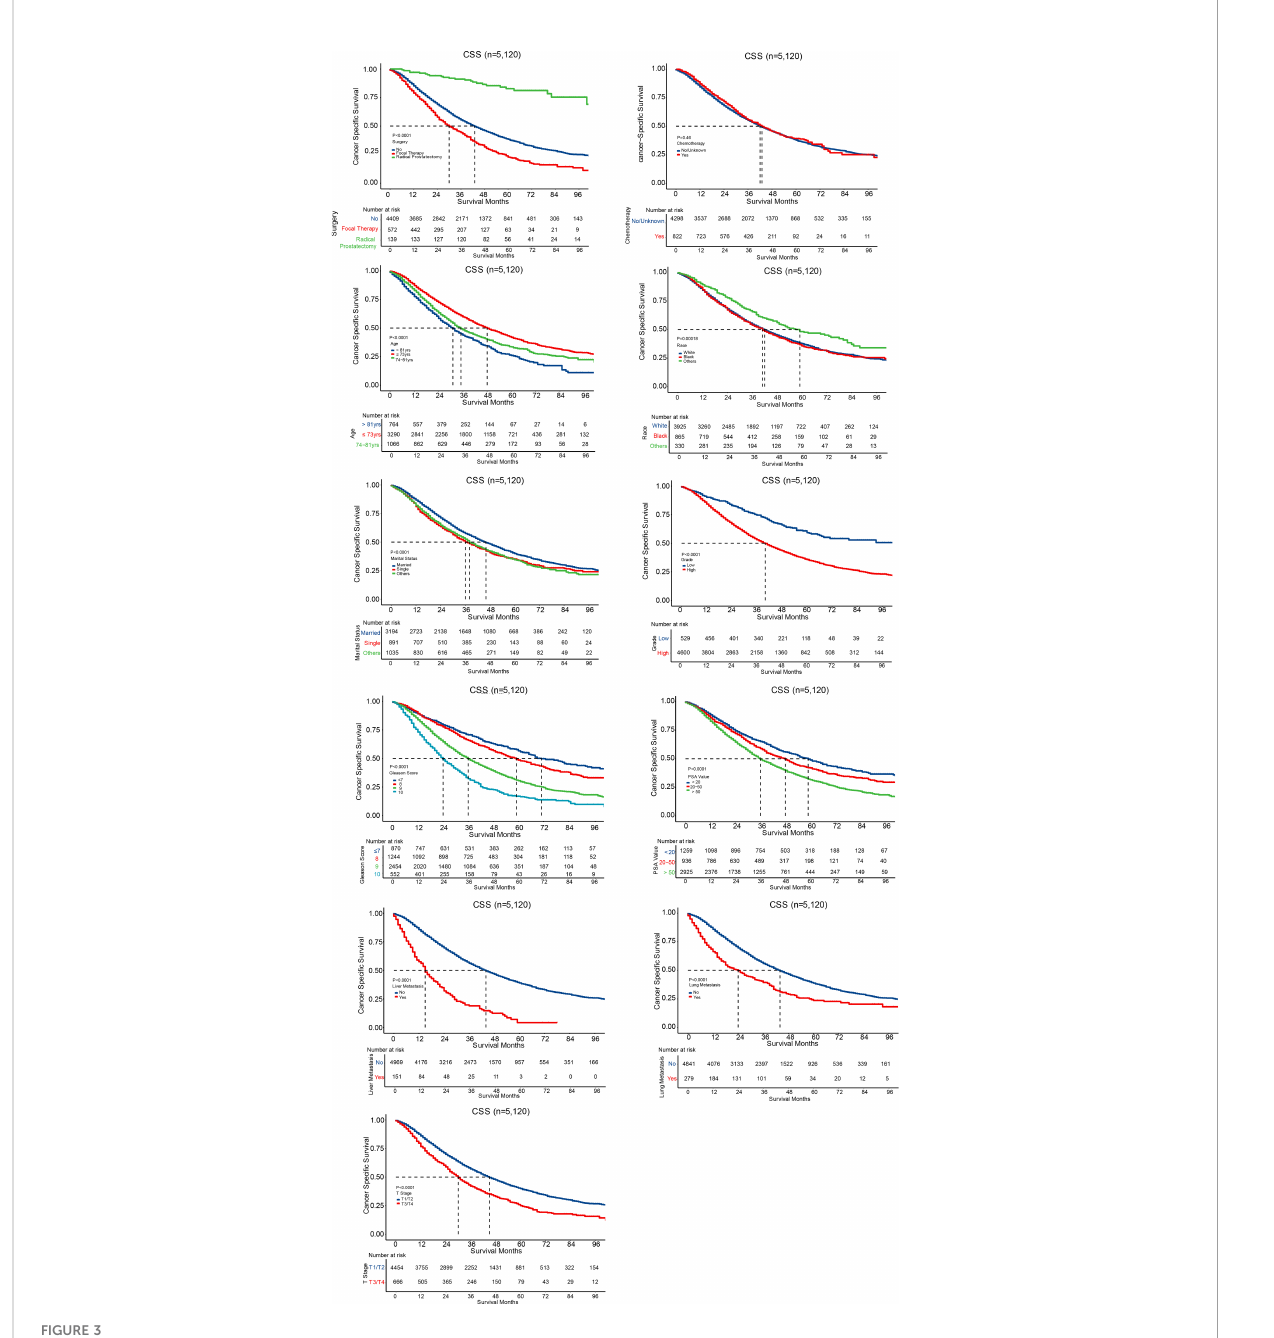
FIGURE 3 Survival curves for